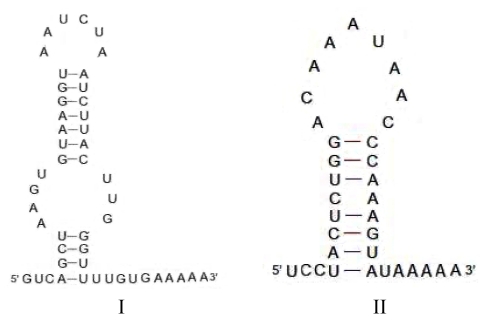
Putative secondary structure inferred from the tail region of Cn-SINEs. (I) with two loops inferred from the sequence of clone CnT33. (II) with one loop inferred from that of clone CnT49.